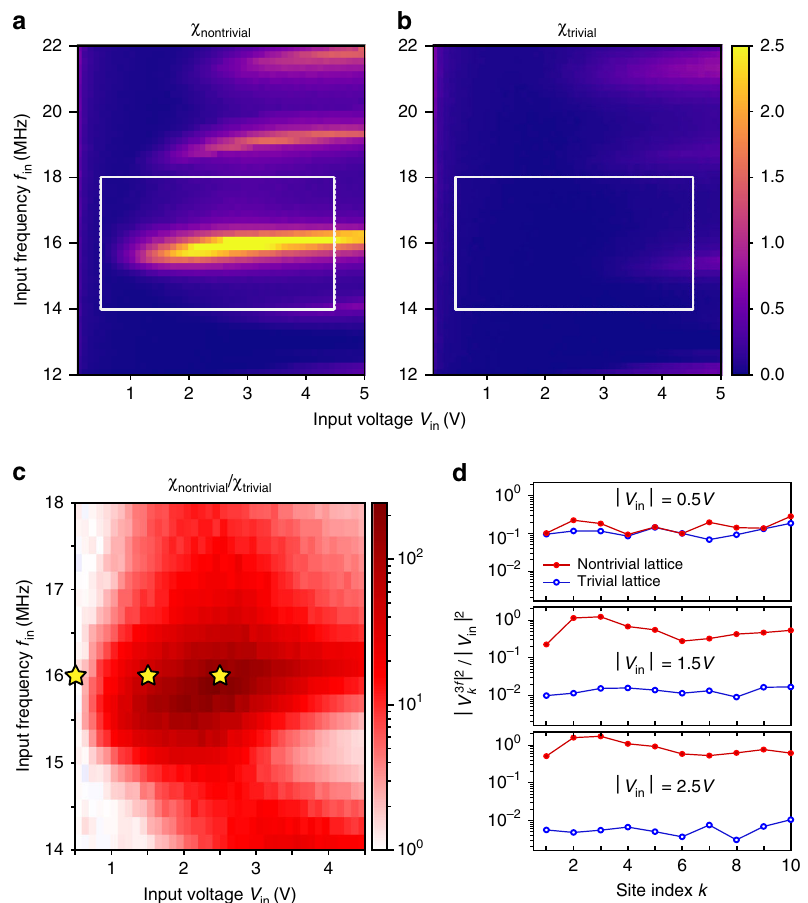
Fig. 3 Measured third-harmonic signal intensities in the nonlinear circuit. a , b Normalized third-harmonic signal intensity χ versus input frequency f in and input voltage V in , for the a nontrivial lattice and b trivial lattice. Here, χ is derived from experimental data using the de fi nition (6). c Ratio of the trivial and nontrivial intensities, χ nontrivial / χ trivial , within the region indicated by boxes in a and b . d Measured third-harmonic intensities (normalized to the input signal) at different sites, for the three sets of input parameters indicated by stars in c : V in = 0.5 V, 1.5 V, and 2.5 V, with fi xed f in = 16